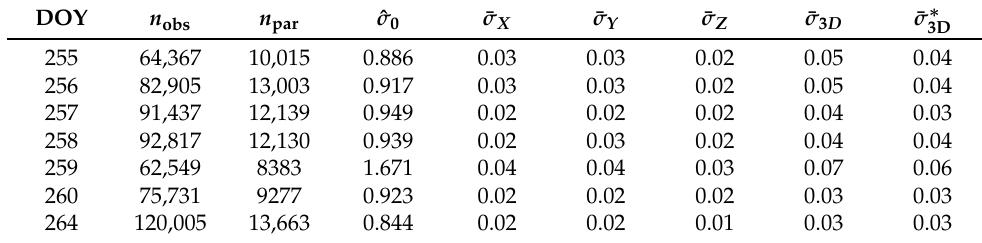
Table 2. Experiment-wise benchmark data of the bundle adjustments derived by JAiCov: n obs and n par are the number of observations and unknowns, respectively. ˆ σ 2 the unit weight. The mean standard deviations of the telescope points are given by ¯ σ X , ¯ σ Y , ¯ σ Z , (cid:113) + ¯ σ 2 + ¯ σ 2 ¯ σ 2 and ¯ σ 3D = . ¯ σ ∗ denotes the corresponding mean overall standard deviation of the X Z 3D Y bundle adjustment. Standard deviations are given in